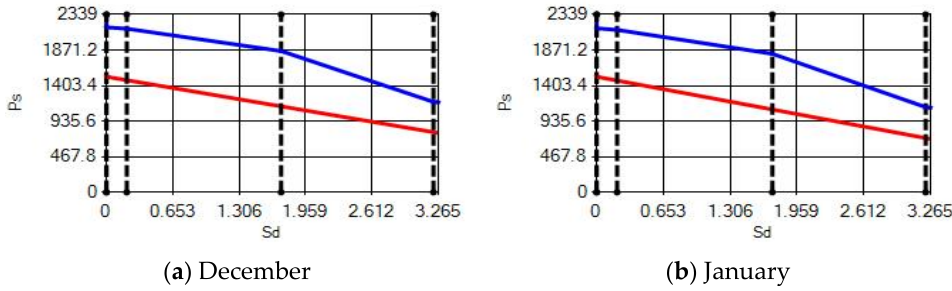
Figure 18. Condensation and evaporation amount chart in the building elements of the brick external wall for the 1st zone for ( a ) December and ( b ) January.